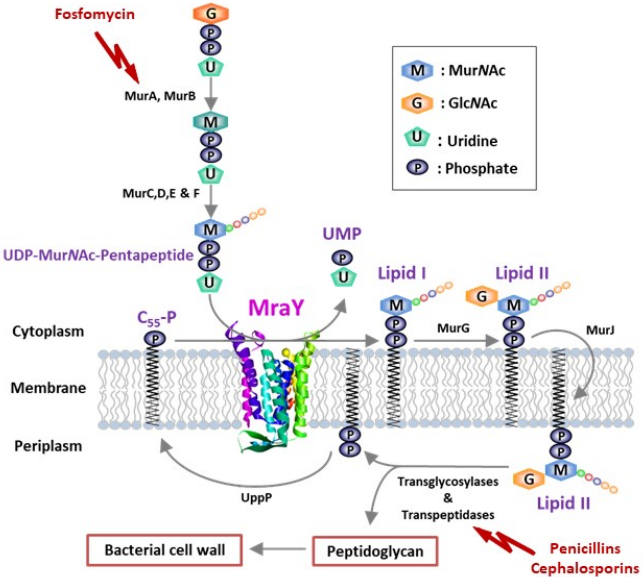
Figure 1. Reaction catalyzed by the bacterial transferase MraY in peptidoglycan